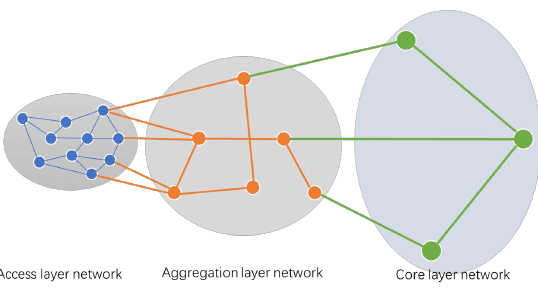
Figure 3. Example of the backhaul transport network in a simulation timestamp.